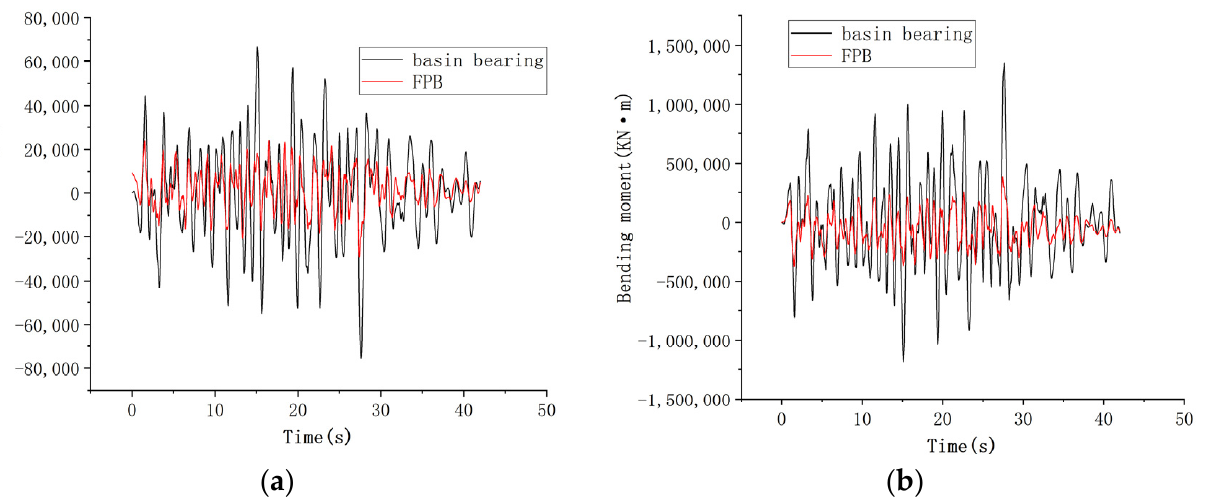
Figure 14. Seismic and isolation structure of time history curve of the 1# pier bottom. ( a ) Shear time history curve of the 1# pier bottom. ( b ) Moment time history curve of the 1# pier bottom.